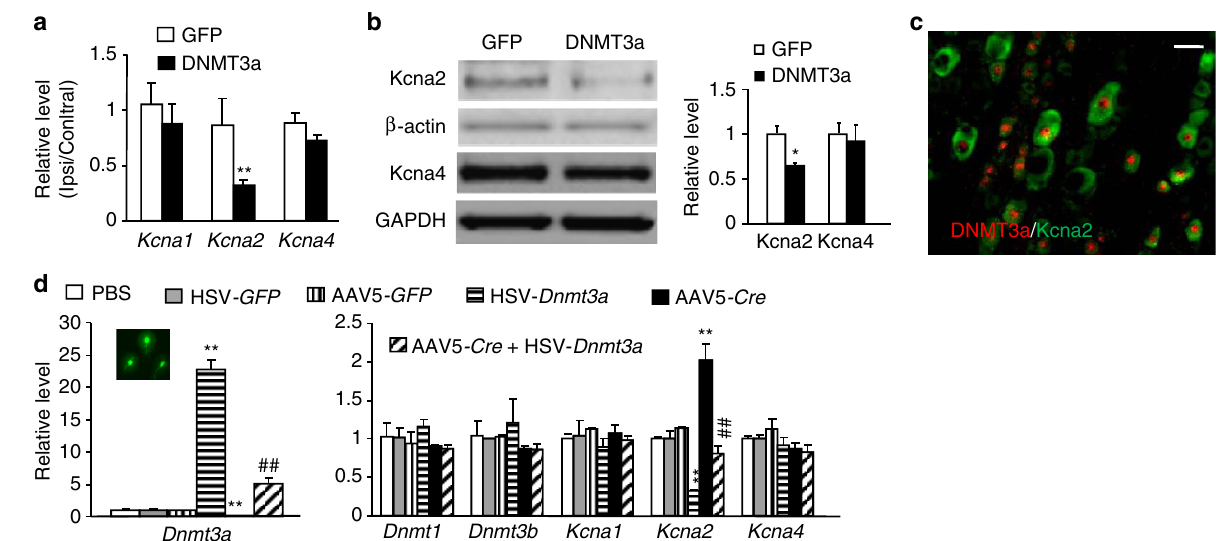
Figure 8 | DRG DNMT3a overexpression represses Kcna2 expression. ( a , b ) Levels of Kcna1 , Kcna2 , and Kcna4 mRNAs on the ipsilateral (Ipsi) or contralateral (Contral) sides ( a ) and levels of Kcna2 and Kcna4 proteins on the ipsilateral side ( b ) 8 weeks after microinjection of AAV5- Dnmt3a (DNMT3a) or AAV5- GFP (GFP) into the unilateral L4/5 DRG. n ¼ 6 rats/group. * P o 0.05 or ** P o 0.01 versus the corresponding GFP group by two-tailed unpaired Student’s t -test. Full-length blots are presented in Supplementary Fig. 6. ( c ) Co-localization of DNMT3a with Kcna2 in rat L5 DRG neurons. Scale bar, 40 m m. ( d ) Amounts of Dnmt3a, Dnmt1, Dnmt3b, Kcna1, Kcna2 and Kcna4 mRNAs in Dnmt3a fl/fl mouse DRG cultured neurons transduced with PBS or virus as indicated. Inset: GFP-labelled neurons. n ¼ 3 repeats per group. One-way ANOVA (relative level versus. group) followed by post hoc Tukey test, F group (5, 17) ¼ 136.9 for Dnmt3a , F group (5, 17) ¼ 0.85 for Dnmt1 , F group (5, 17) ¼ 0.67 for Dnmt3b , F group (5, 17) ¼ 0.56 for Kcna1 , F group (5, 17) ¼ 38.1 for Kcna2 , and F group (5, 17) ¼ 1.52 for Kcna4 . ** P o 0.01 versus the corresponding PBS group. ## P o 0.01 versus the corresponding AAV5- Cre -treated group.